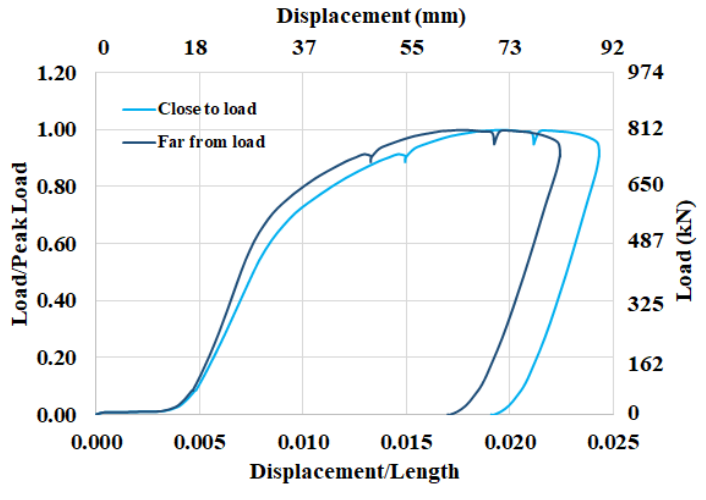
Figure 10. Load-displacement curve of test beam test-2.